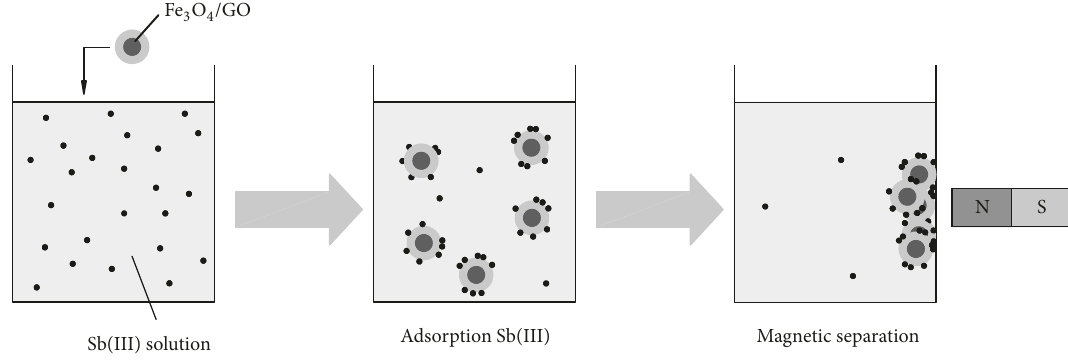
Figure 1: The adsorption experiment